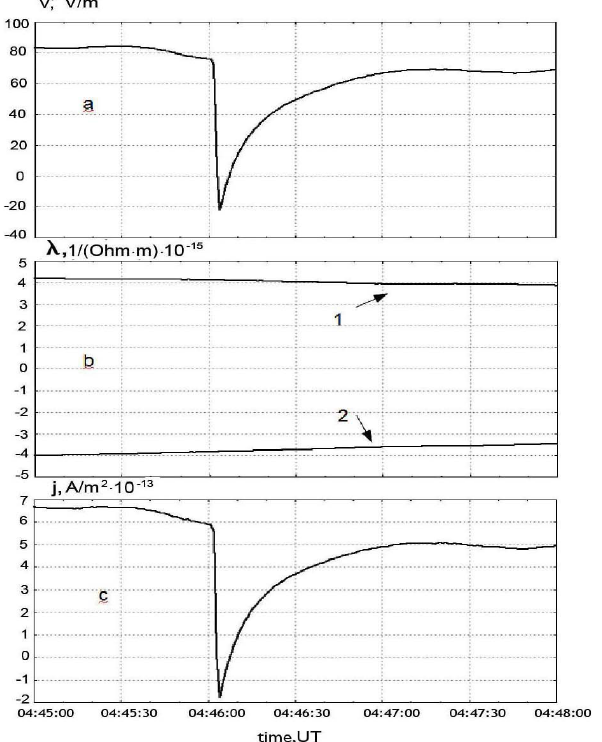
Fig. 3. Plot of field pattern during lightning discharge on October 2, 2008: a) electric field (Ez) potential gradient in the near ground air; b) air electroconductivity (λ) caused by 1-negative ions and 2- positive ions with factor (-1); c) conduction current density (j).